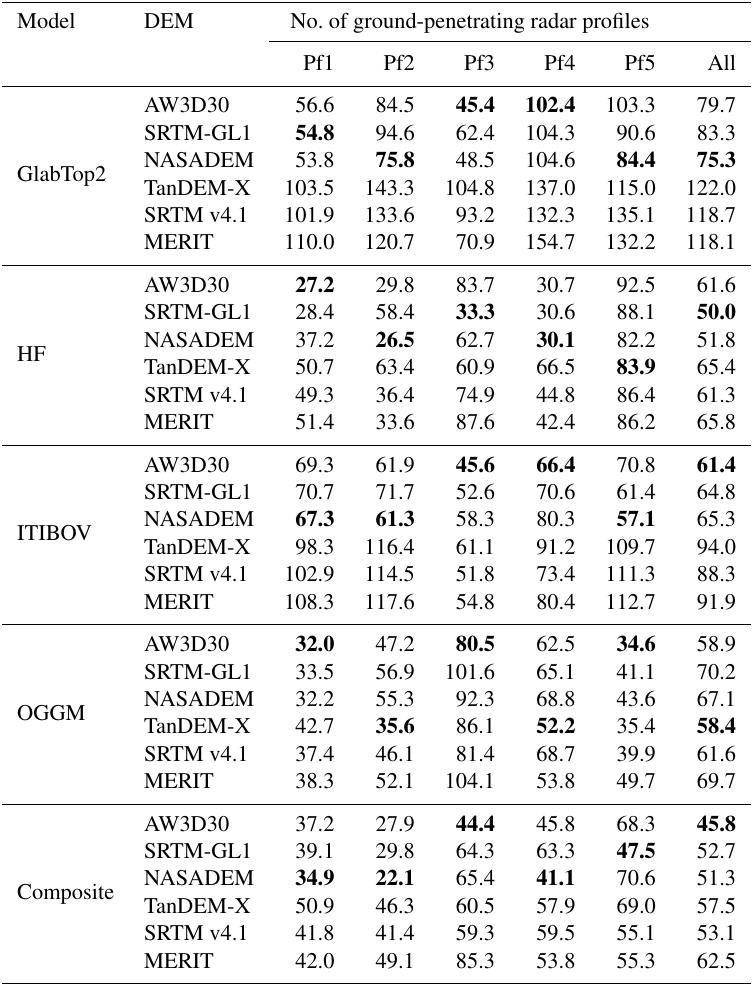
Table 2. Root mean squared error (RMSE, m) of modeled ice thickness compared with ground-penetrating radar (GPR) measurements on each profile (Pf1 to Pf5). The locations of profiles are shown in Fig. 1. Bold numbers denote the best model performance on each profile using different